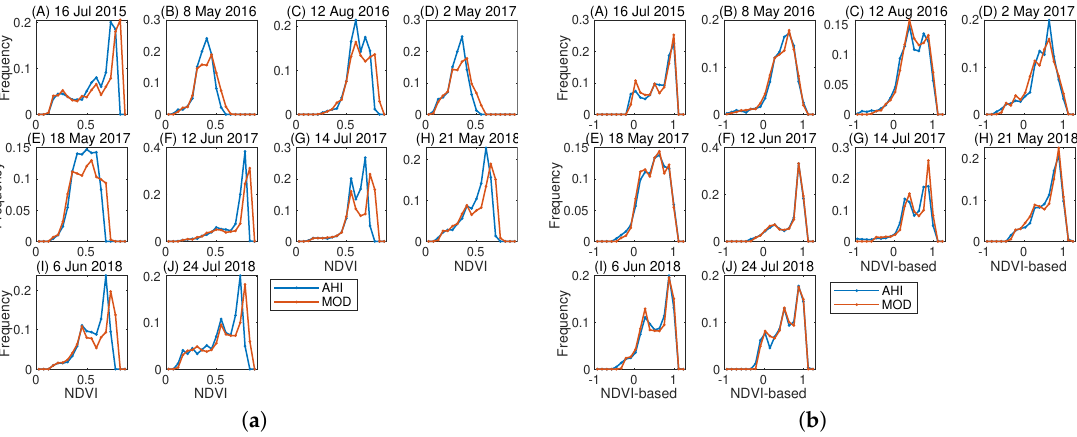
Figure 7. ( a ) Relative frequency distribution of the NDVI over the Hokkaido region. ( b ) NDVI-based index. Table 4. Summary of the statistical analyses comparing the AHI and MODIS NDVIs as well as the AHI and MODIS NDVI-based indices over the Hokkaido region. N is the sample number of pixels used on each date. θ a is the solar zenith angle for the AHI average value over the area on each